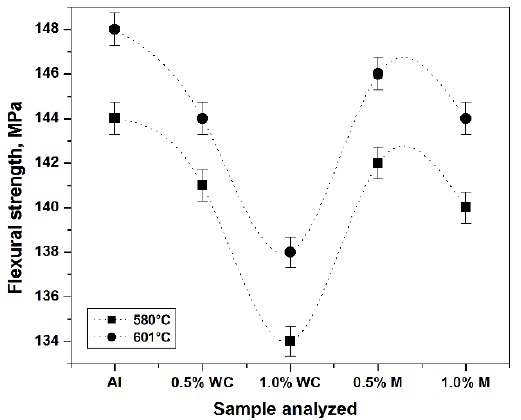
Figure 8. Results of the flexural strength measurements of the samples with different compositions and sintered at different temperatures.